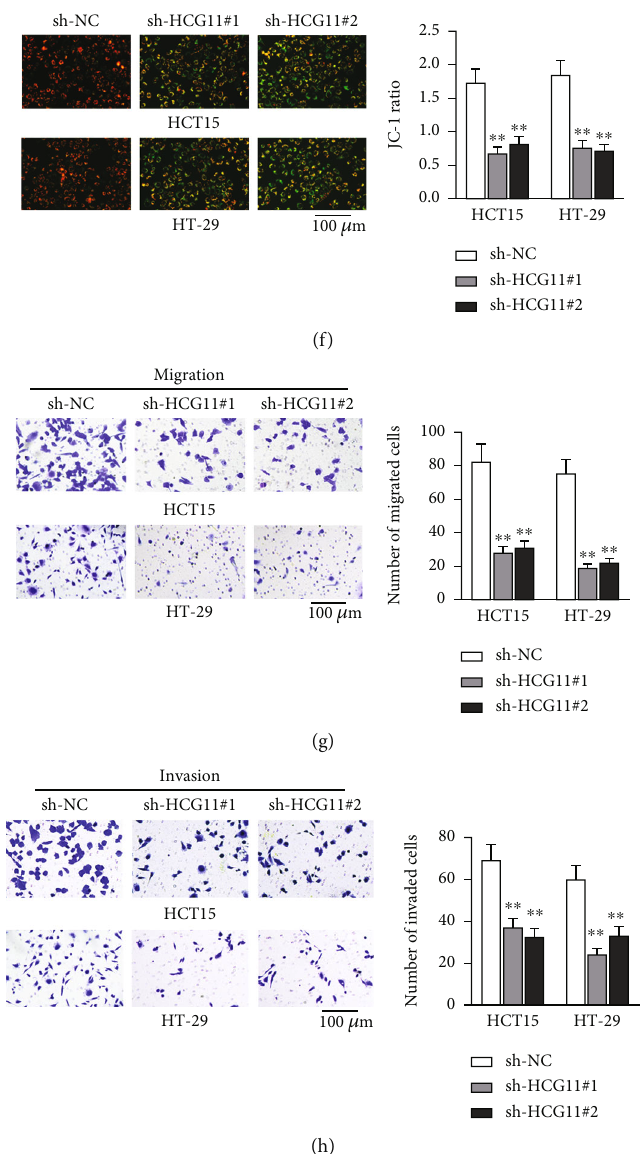
Figure 1: lncRNA HCG11 knockdown subdues CRC cell growth and accelerates cell apoptosis. (a) HCG11 level in CRC cell lines (HCT15, HT-29, and LOVO) and human normal intestinal epithelial cells (NCM-460) was assessed using qRT-PCR. (b) qRT-PCR tested the interference e ffi ciency of sh-HCG11 in HCT15 and HT-29. (c, d) The cell proliferation and colony capacities were evaluated with the assistance of EdU assay and colony formation assay. (e, f) Cell apoptosis was assessed via TUNEL assay and JC-1 assay. (g, h) Cell migration and invasion abilities were tested via transwell assay. ∗ p < 0 : 05 and ∗∗ p < 0 : 01